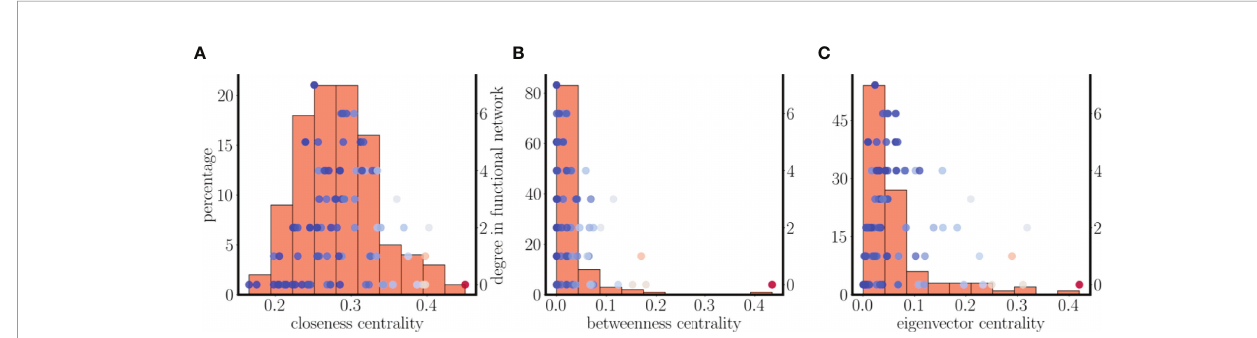
FIGURE 11 | Relationship between centrality distributions and functional and structural degrees of the nodes in the random scale-free network of Figure 9 . (A) Histogram of closeness centrality of nodes in the structural network (bars). The superimposed points are a scatter plot of the functional degree (for one set of initial conditions) versus the closeness centrality for each node, while the color of the points indicates the structural degree (hot colors indicate high degree). The nodes with highest functional degree are near the mean of the centrality distribution. (B) The distribution and scatter plot are left-skewed in terms of betweenness centrality. (C) There is little overlap of the eigenvector distribution and functional degree scatter